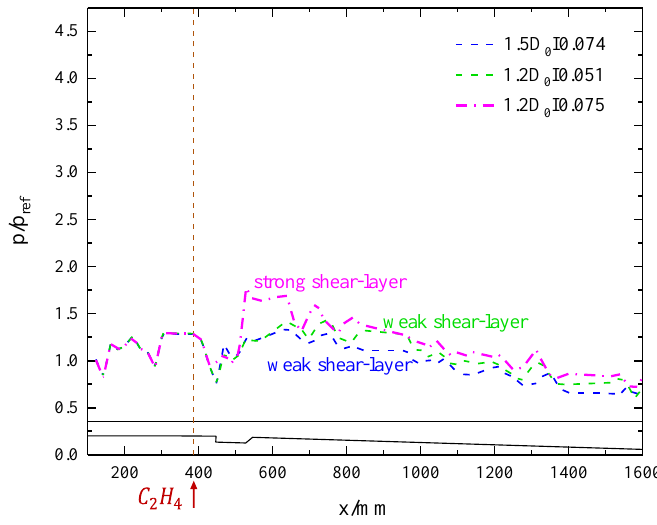
Figure 17. Dimensionless pressure along x axis to different injectors at more equivalence ratio.